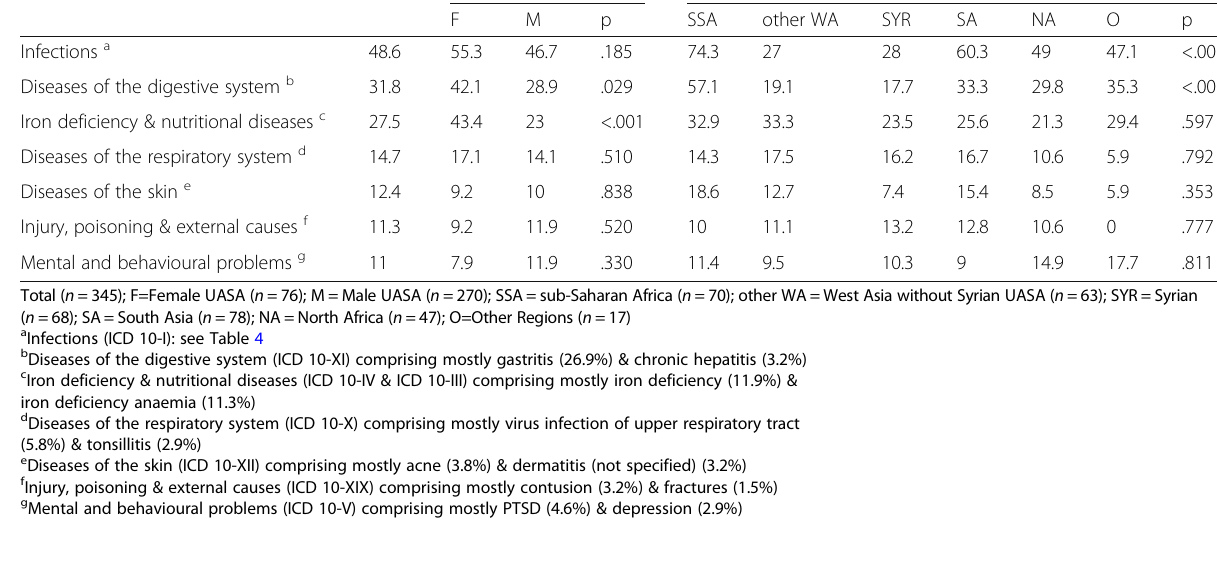
Table 3 Prevalences (%) in UASA with one or more diseases within the most common diagnosis categories ICD-10